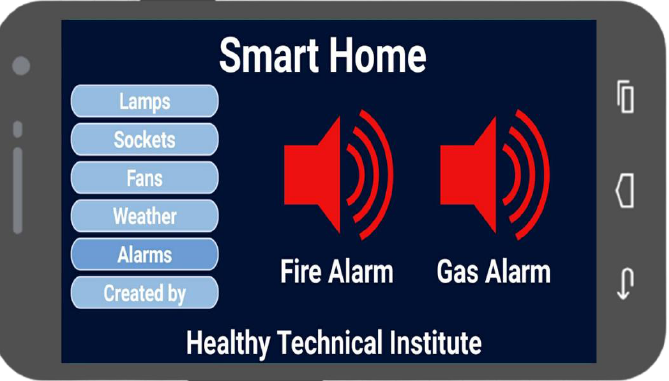
Figure 9. The control circuit for displaying the temperature and humidity in the smart home.